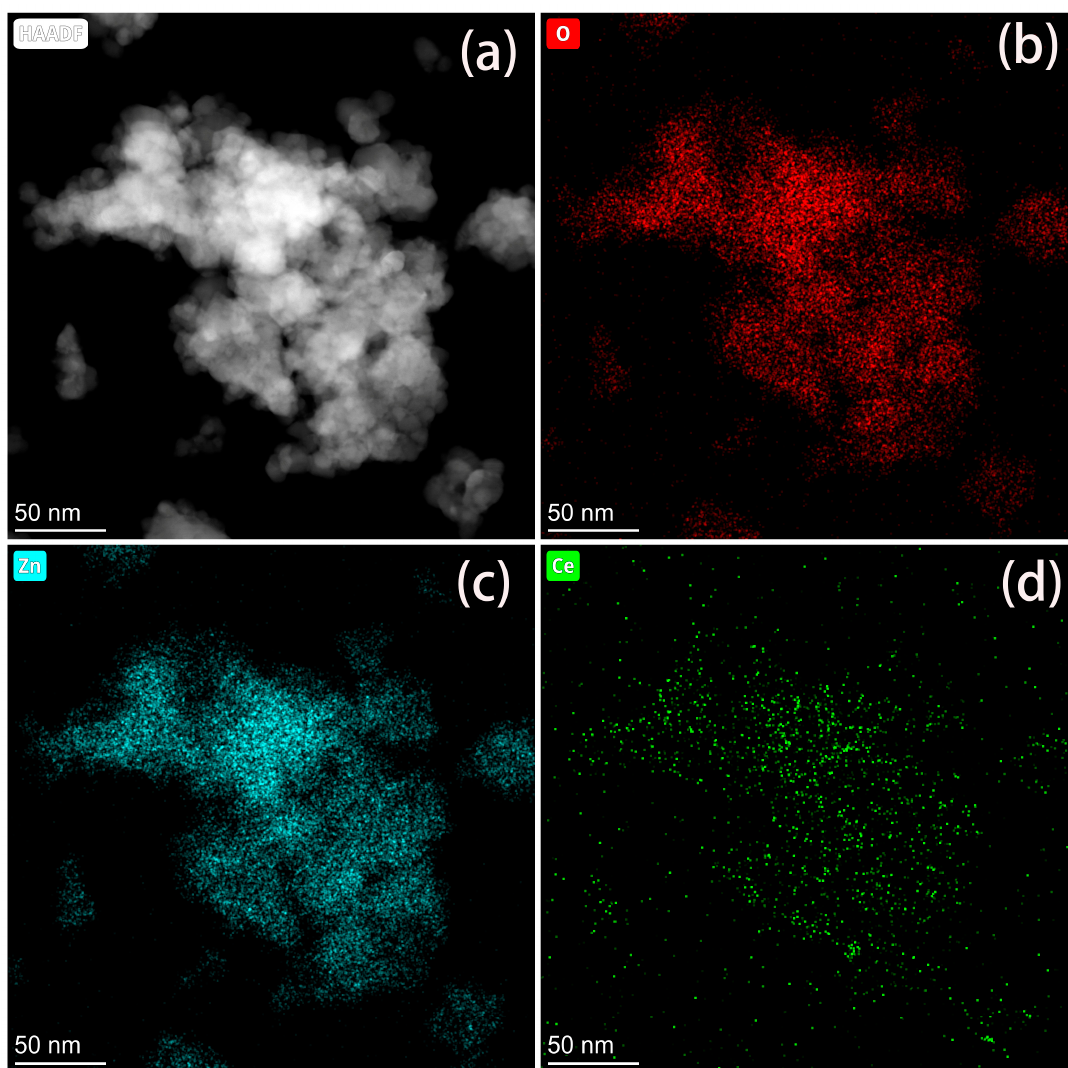
Figure 4. ( a ) Scanning tunneling electron microscopy high-angle annular dark field image of CeO 2 @ZnO-0.67 and the corresponding ( b ) O, ( c ) Zn, and ( d ) Ce elemental maps.